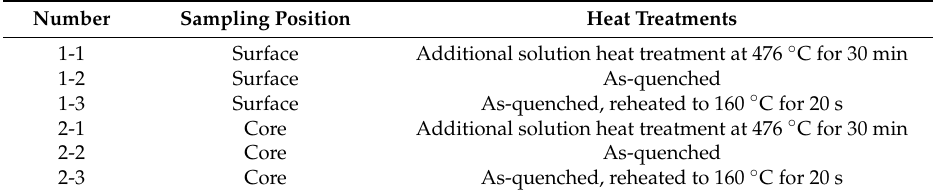
Figure 4. ( a ) Yield strength and ( b ) Electrical conductivity of surface and center of 115 mm-7050 aluminum alloy plate with different heat treatments. Table 2. Heat treatments for the compression samples.